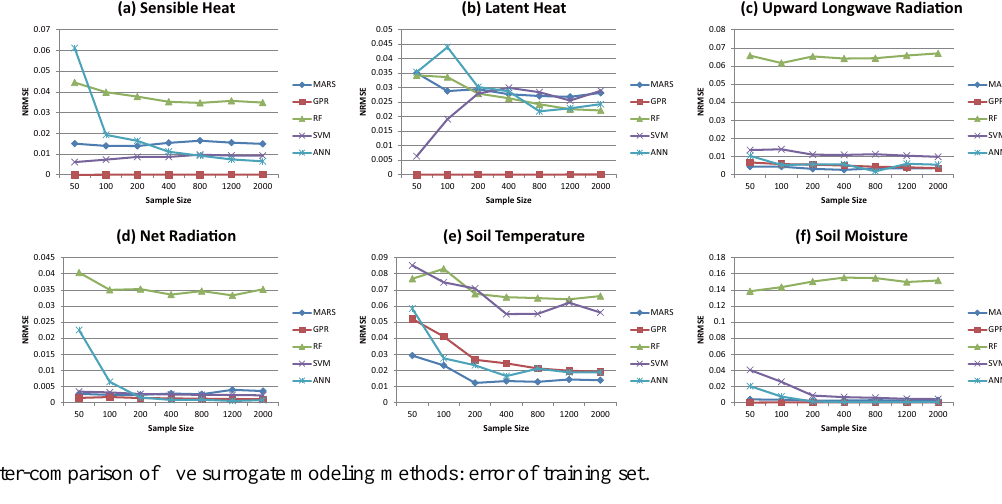
Figure 1. Inter-comparison of five surrogate modeling methods: error of training set.